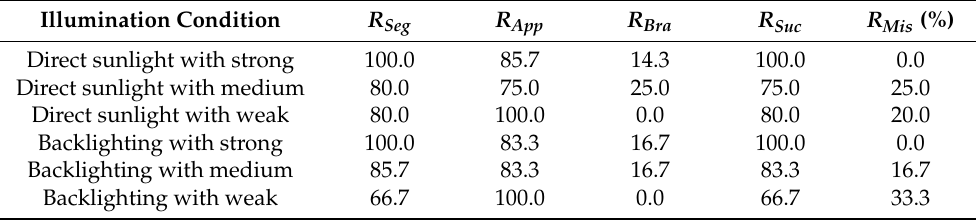
Table 9. Apple image segmentation effect comparison under six illumination